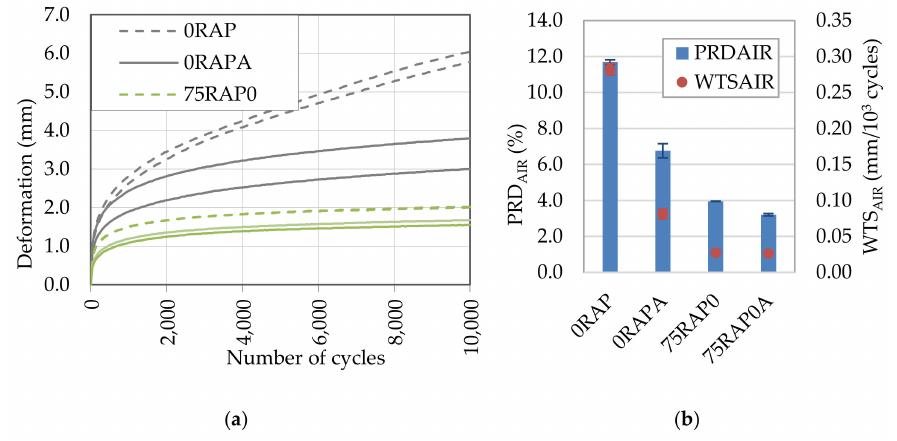
Figure 10. Permanent deformation performance: ( a ) wheel-tracking deformation curves; ( b ) WTS AIR and PRD AIR